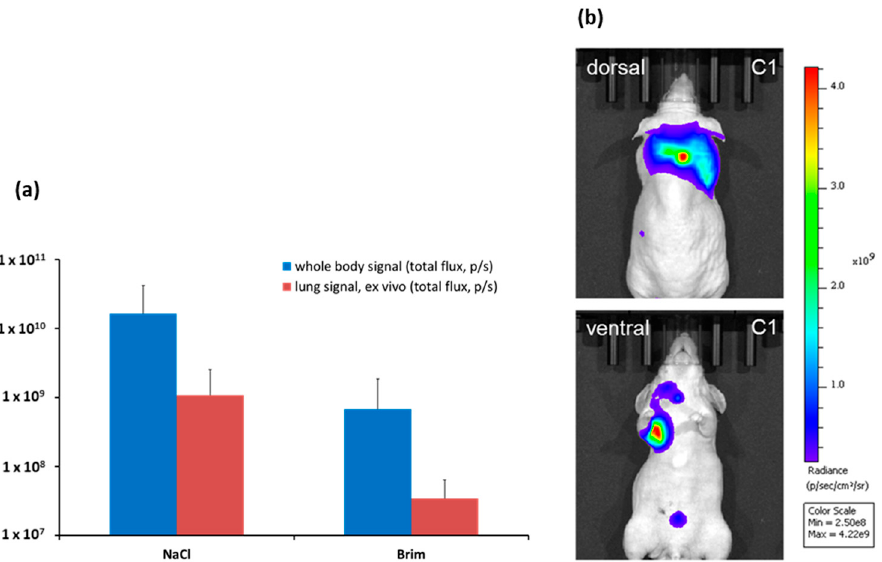
Figure 6. Antimetastatic activity of brimamin in the HT29 tumor model of disseminated tumor cells. Nude mice were injected i.v. with luciferase-expressing HT29-Luc cells, and then treated with NaCl